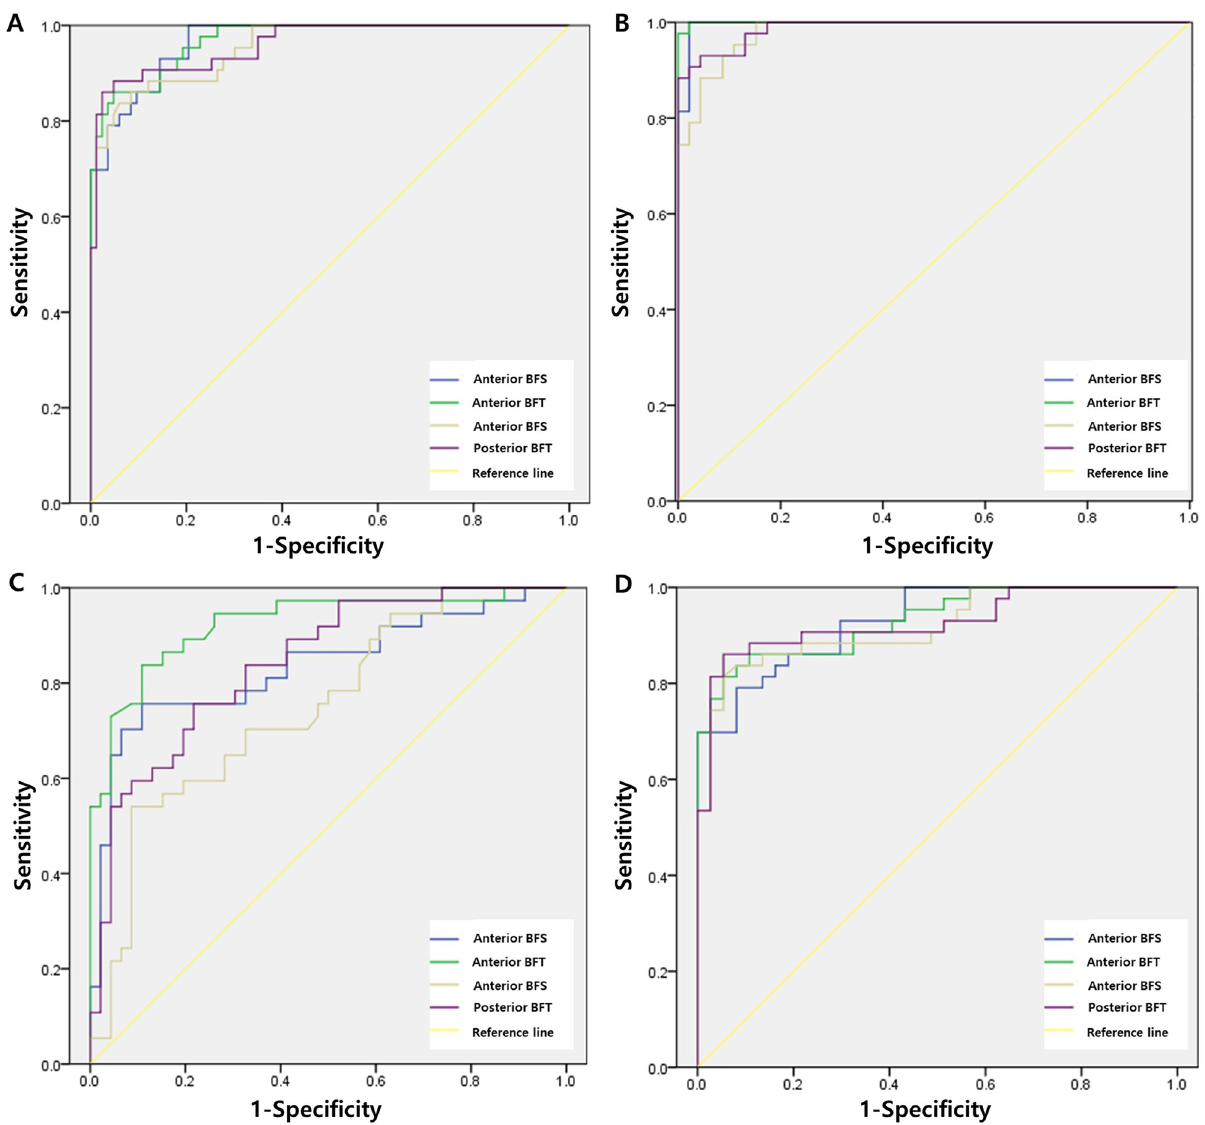
Fig 1. Receiver operator characteristic (ROC) curves analysis for keratoconus versus keratoconus suspect or normal cornea. (A) ROC curves for keratoconus versus normal and keratoconus suspect cornea (B) ROC curves for normal versus keratoconus cornea (C) ROC curves for keratoconus suspect versus normal cornea (D) ROC curves for keratoconus versus keratoconus suspect cornea. and 0.953 and 0.961 for the anterior BFS and BFT and posterior BFS and BFT, respectively. The independent ROC values for the normal corneal group and the keratoconus group were 0.987 (versus normal group) and 0.920 (versus keratoconus suspect group) for anterior BFS, 1.000 (versus normal group) and 0.926 (versus keratoconus suspect group) for anterior BFT, 0.979 (versus normal group) and 0.917 (versus keratoconus suspect group) for posterior BFS, and 0.991 (versus normal group) and 0.932 (versus keratoconus suspect group) for posterior BFT. In addition, the highest ROC value was observed when the BFT reference surface was used to diagnose keratoconus. Table 3 shows the results of the ROC curve analysis, best cut-off point, and sensitivity and specificity of the best cut-off points for each parameter tested in the